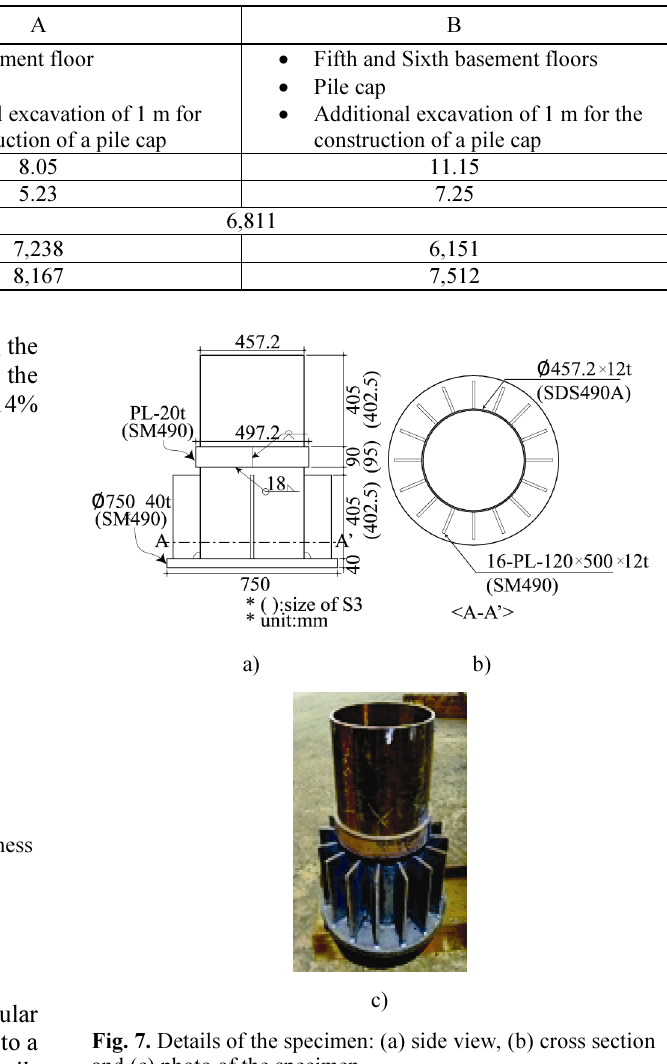
Table 3. Excavation plans for the case substructure